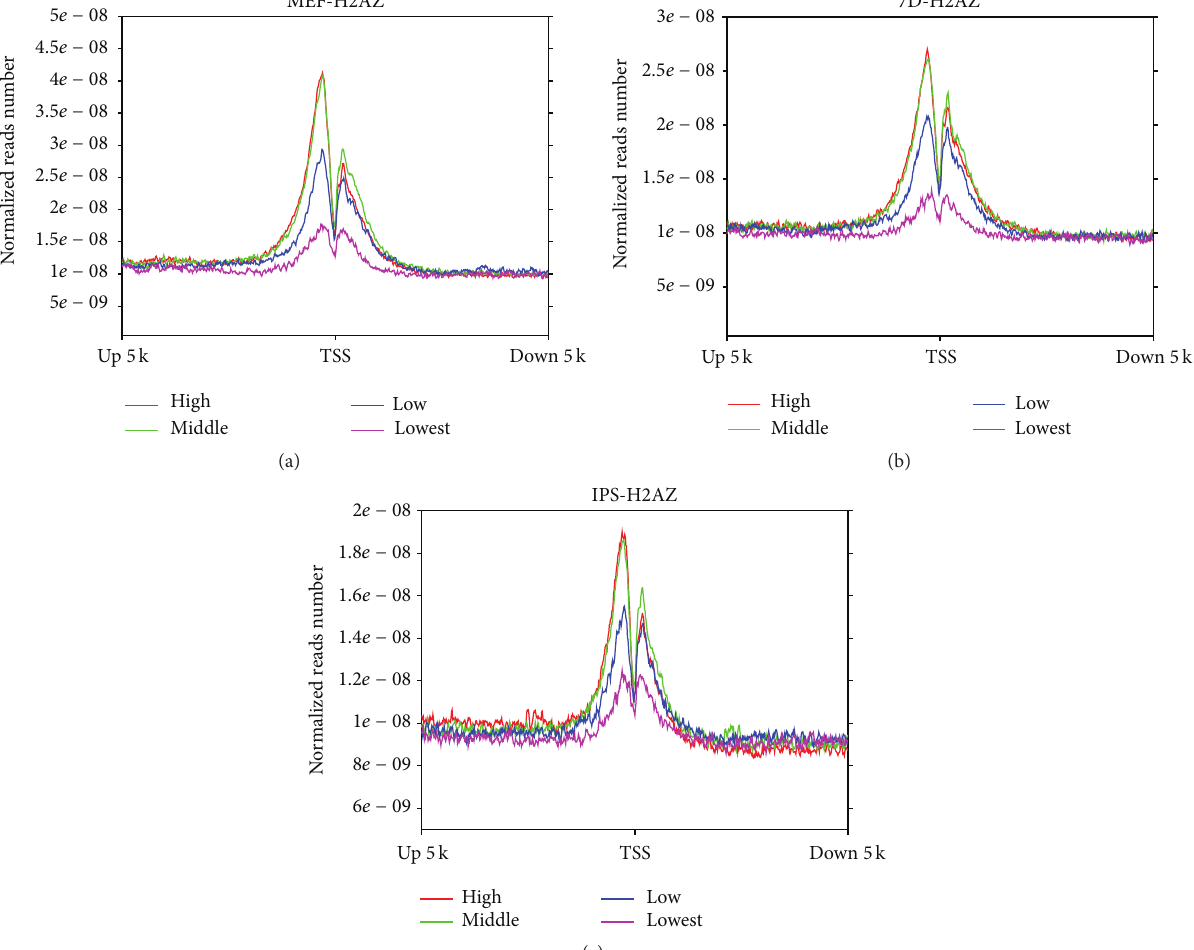
these processes were occupied by H2A.Z in Day 7 cells and MEFs (Figure